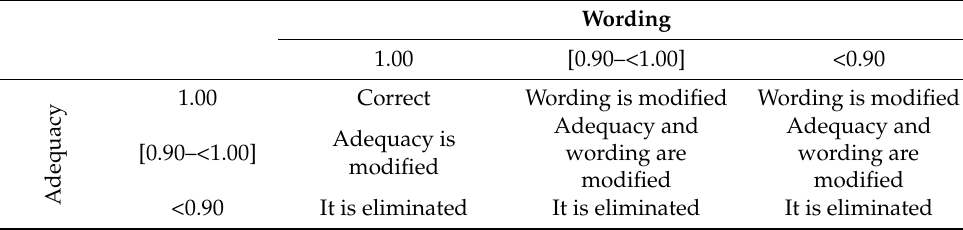
Table 3. Criteria to follow for the acceptance, modification, or elimination of the variables.